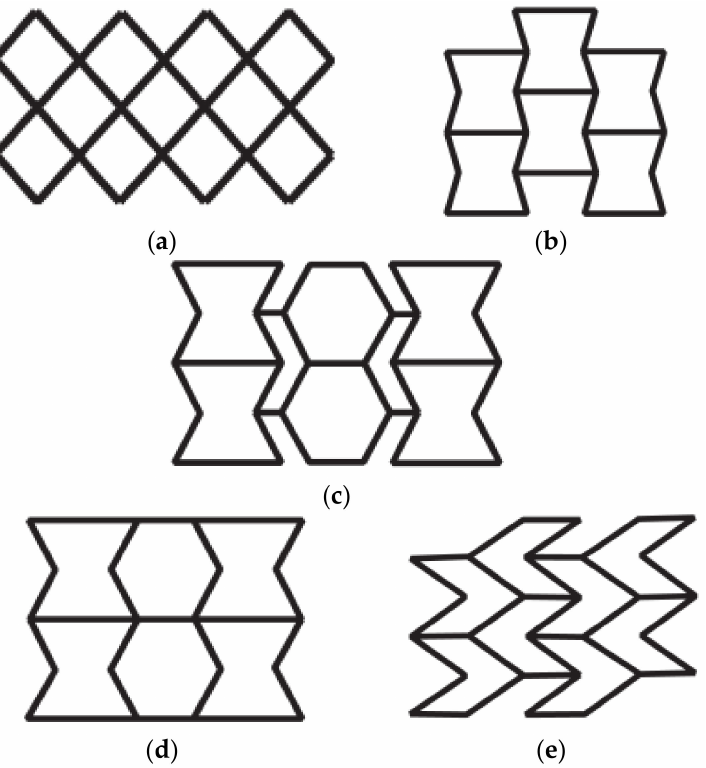
Figure 13. RVE structure of vascular stent [96]: ( a ) Diamond; ( b ) Reentrant Auxetic; ( c ) Hybrid A; ( d ) Hybrid C; ( e ) Chevron